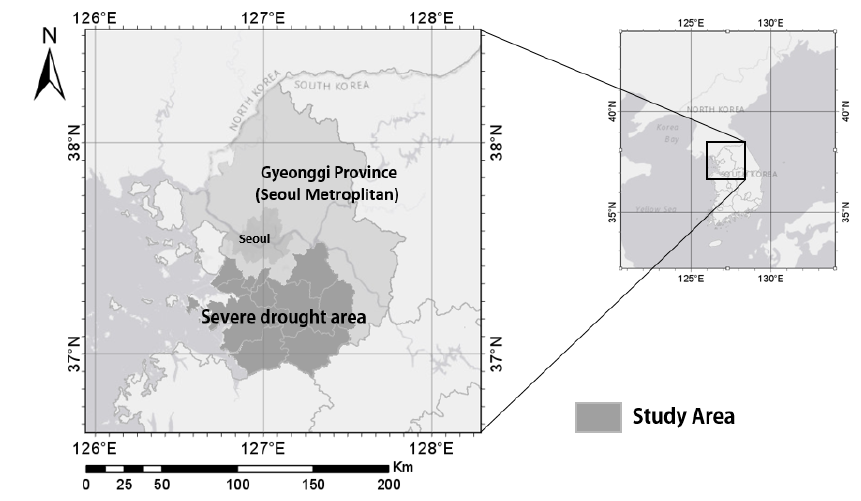
Figure 1. Location of the study area.